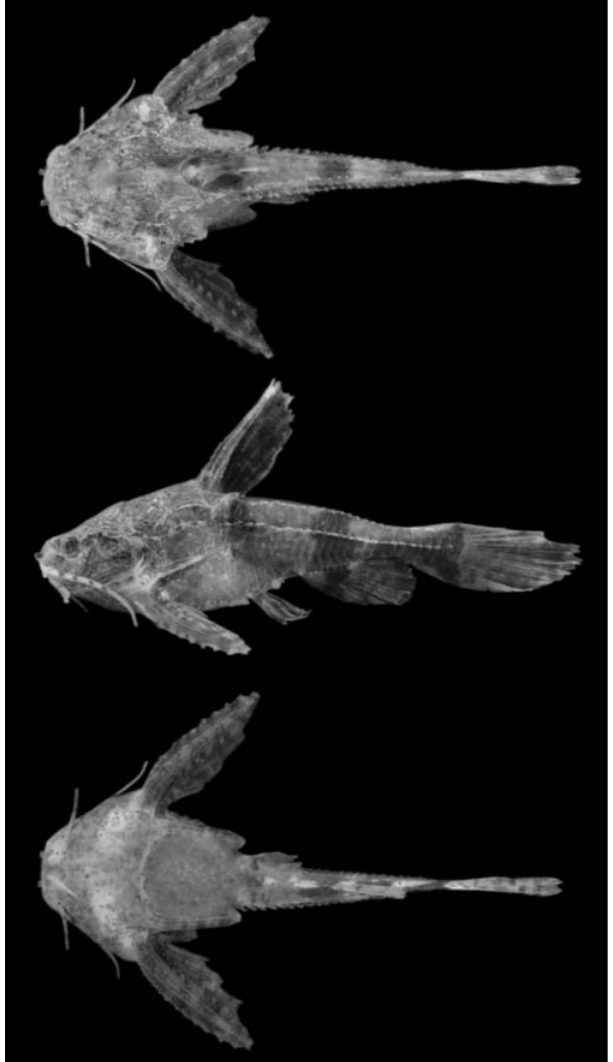
Fig. 5. Physopyxis ananas , holotype, INPA 24324 (13.43 mm SL), rio Jutaí, rio Solimões basin, Amazonas State,